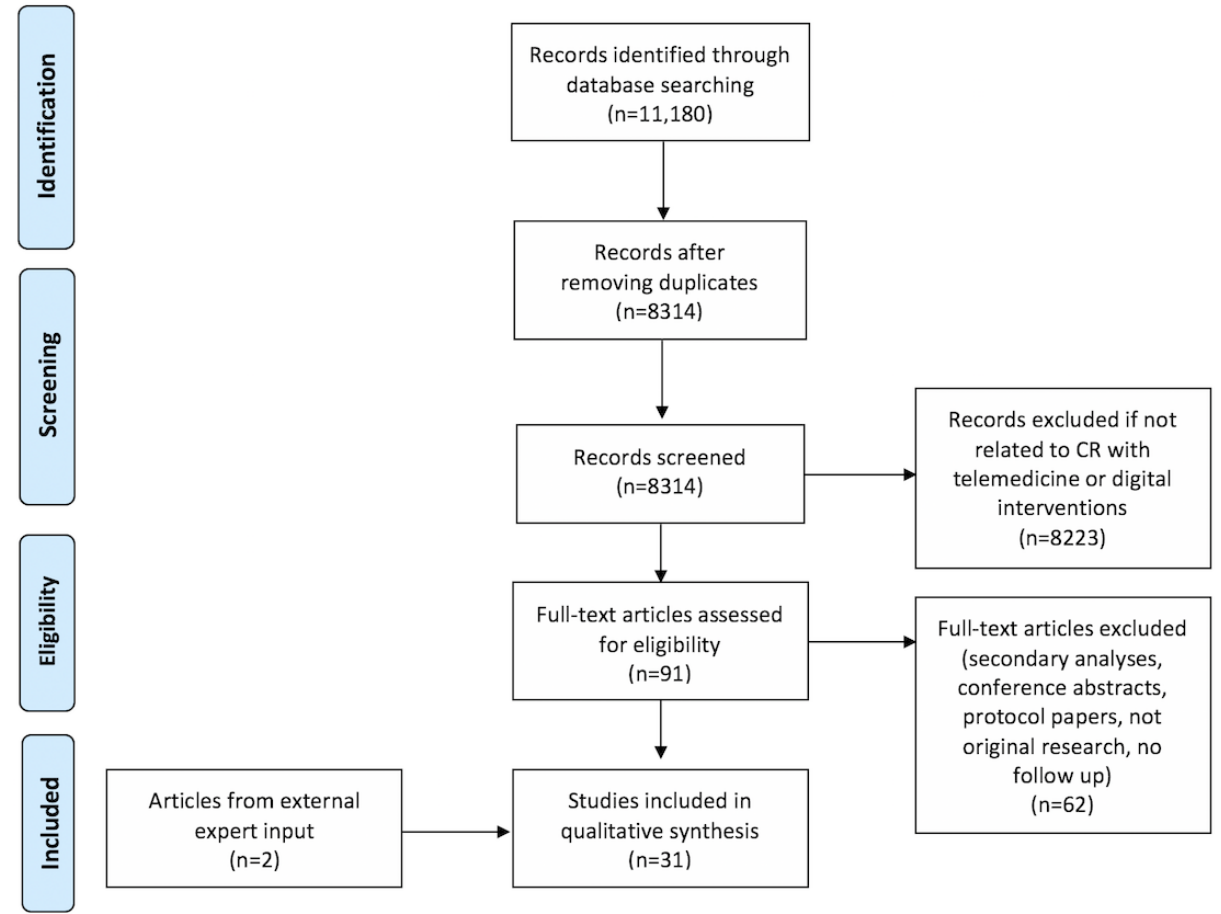
Figure 1. Flowchart for study identification, screening, eligibility, and inclusion. CR: cardiac